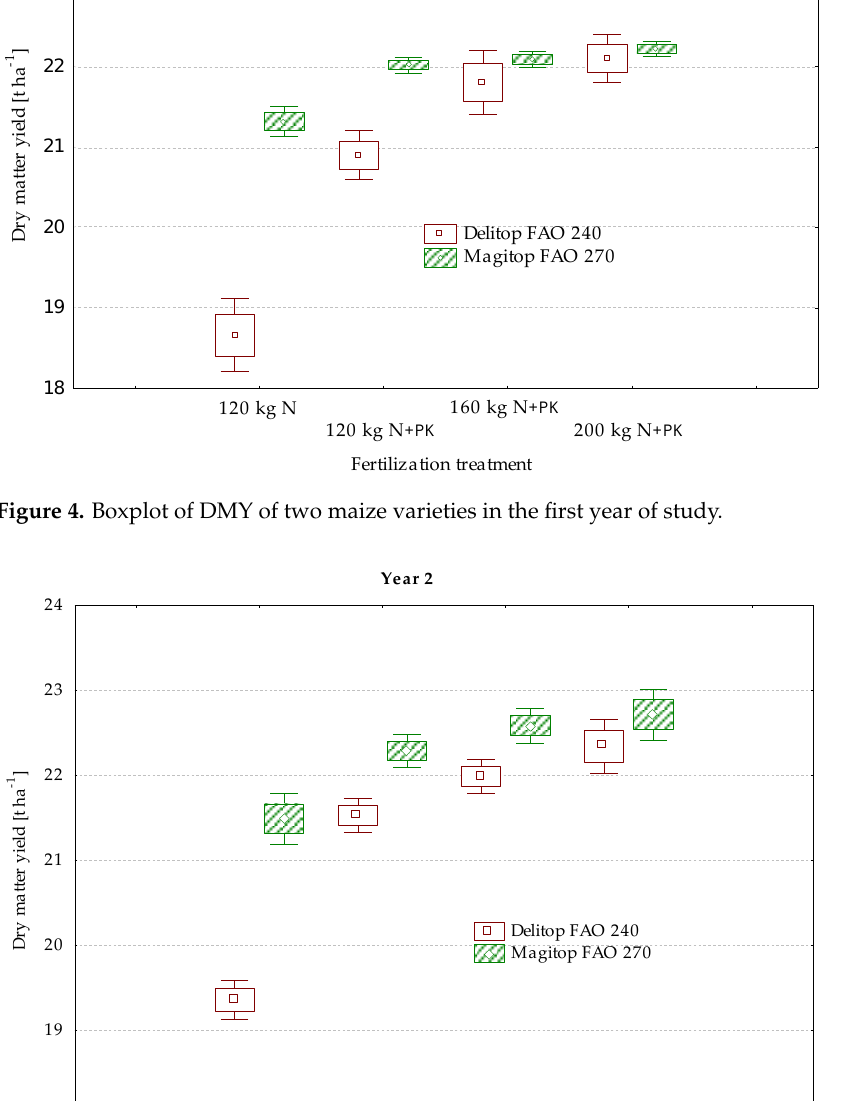
Figure 5. Boxplot of DMY of two maize varieties in the second year of the study.